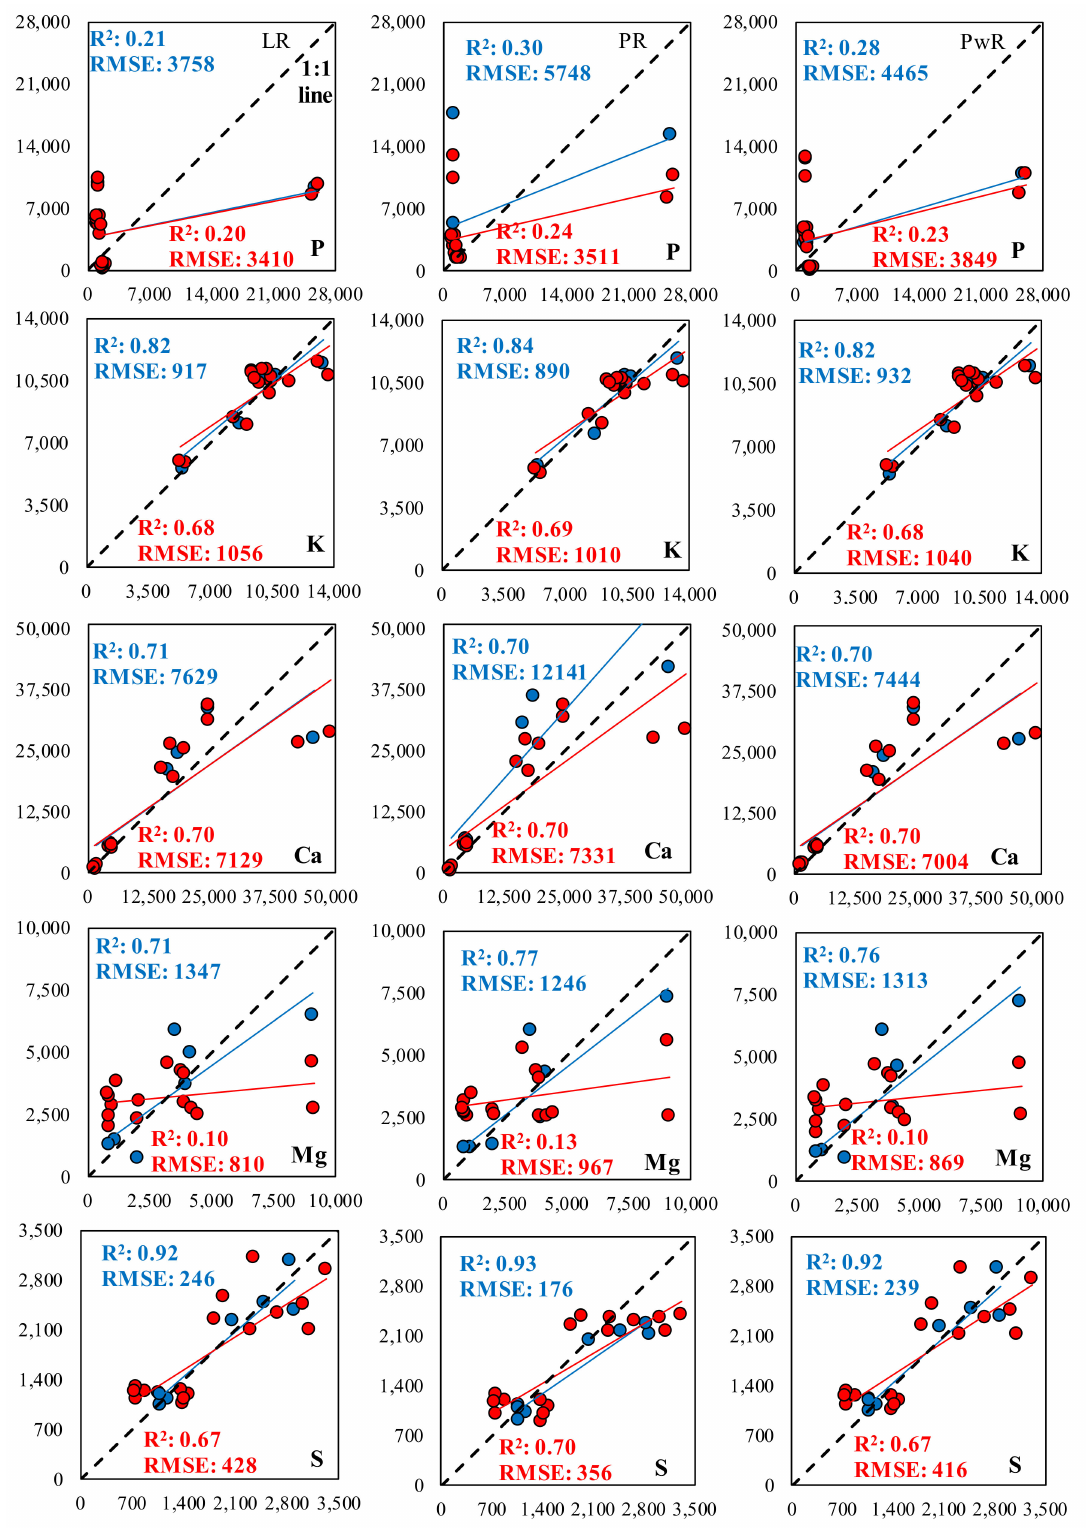
Figure 1. The relationship between the observed ( x -axis) and predicted values ( y -axis), shown in mg kg − 1 , of the nutrient contents (P, K, Ca, Mg, and S) of plant samples. RMSE—root mean square error. The observed values are the actual values obtained, and the predicted values are the values of the variable predicted, based on the regression analysis. Blue and red points are ‘modeling’ and independent (‘validation’ samples) datasets of measurements, respectively. Black dashed lines represent the 1:1 line, and blue and red solid lines represent the actual regression curves from the ‘modeling’ and ‘independent’ datasets,